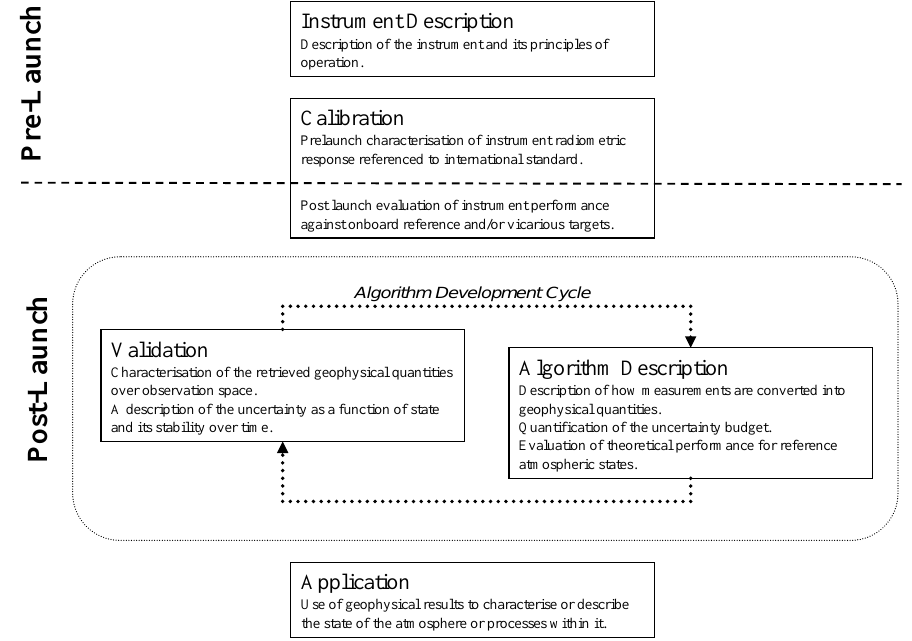
Algorithm Description Description of how measurements are converted into geophysical quantities.